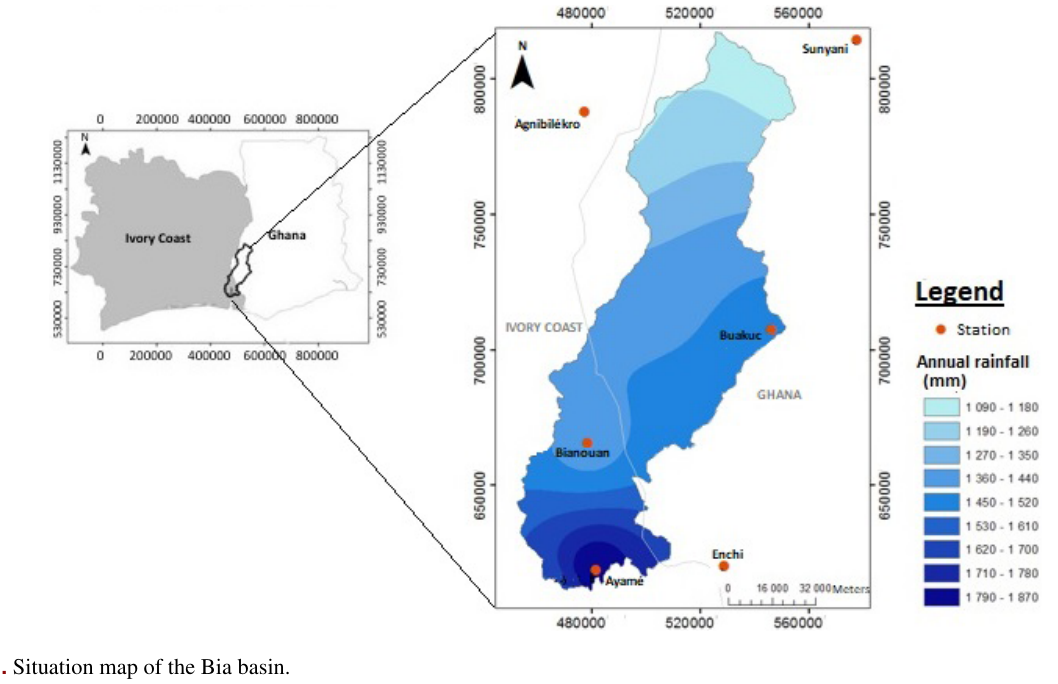
Figure 1. Situation map of the Bia